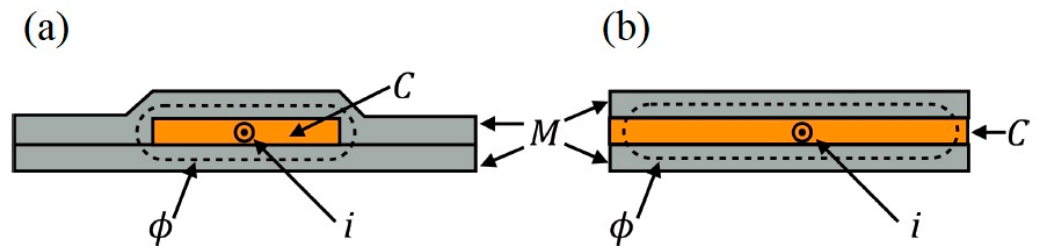
Figure 3. Sandwich structure MI biosensor ( M denotes magnetic layer and C refers to conductive). ( a ) Closed path magnetic flux ϕ as conductive layer is enclosed by the magnetic layers. ( b ) Open path magnetic flux ϕ as conductor is not enclosed by magnetic layers resulting in low MI effect. Reprinted